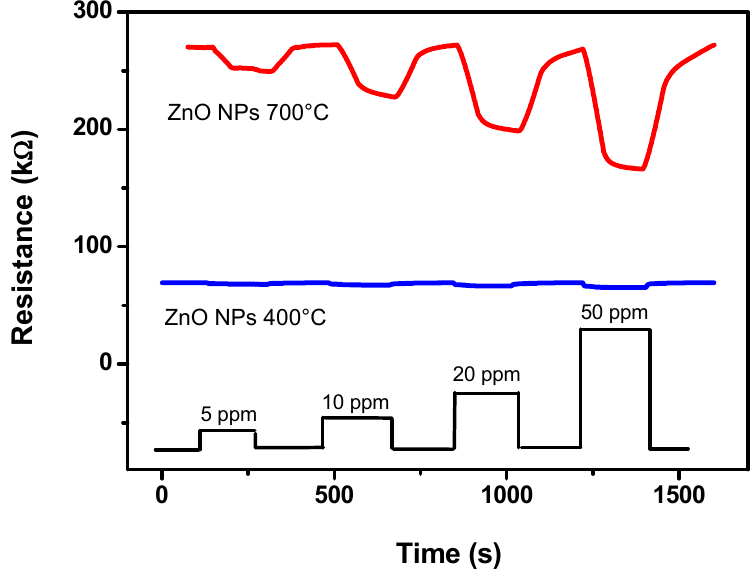
Figure 5. Transient responses to various CO concentrations in air at the operating temperature of 350 °C of the ZnO nanoparticles (NPs) sensor annealed at different temperatures.